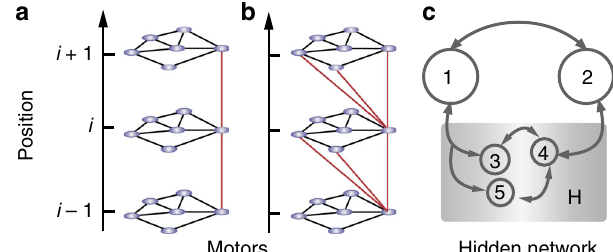
Fig. 2 Decimation of Markov processes. a , b Molecular motor model: An observer with access only to the position (vertical axis) cannot resolve the internal states (circles). a Decimation to position results in a fi rst-order Markov process, since spatial jumps connect the same internal